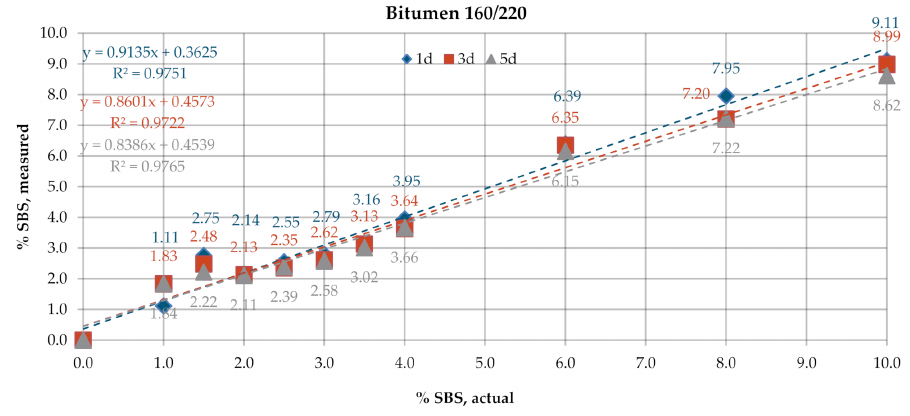
Figure 6. SBS contents in bitumen 160 / 220, obtained by measurement in transmission mode.